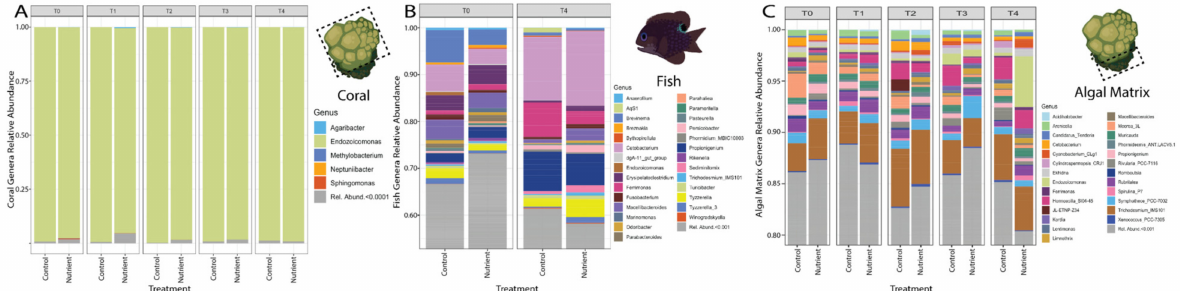
Figure 4. Relative abundance of bacterial genera across the three host microbiomes. ( A ) Over 90–99% of coral microbiomes were dominated by one genera Endozoicomonas . ( B ) Approximately 60–70% of fish microbiomes were dominated by genera with a relative abundance of less than 0.001 and changes in taxa are more apparent across time than across treatment. ( C ) Approximately 80–85% of algal matrix microbiome genera had a relative abundance of less than 0.001 and again, changes in taxa are more apparent across time than across treatment. The range of the y -axis of graphs ( B , C ) have been altered to highlight the more abundant